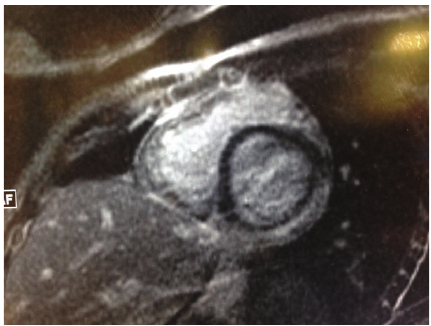
Figure3:CardiacMRIshowingmultiplefociofcurvilinearandoval shapedcontrasthyperenhancementinvolvingthecentralportionsof the anterior, lateral, and inferior wall of LV with relative sparing of the endocardial portions of the myocardial